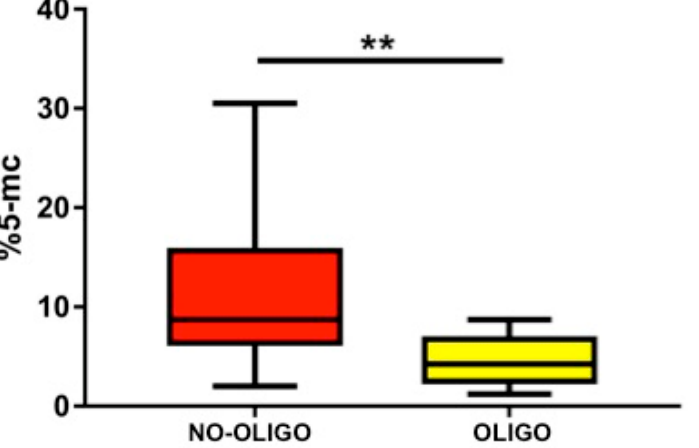
Figure 2. The box plot shows the sperm global DNA methylation (SGDM) (%5-mc) in non oligo- zooospermic/oligozoospermic dogs, in the total study population. NO-OLIGO: Non oligozoo- spermic; OLIGO: Oligozoospermic. A significant difference was found ** p < 0.005.